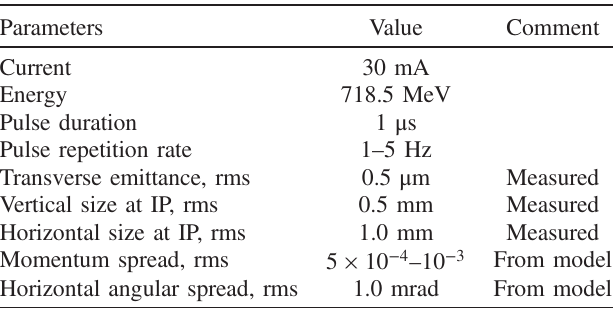
TABLE I. Ion beam parameters in the